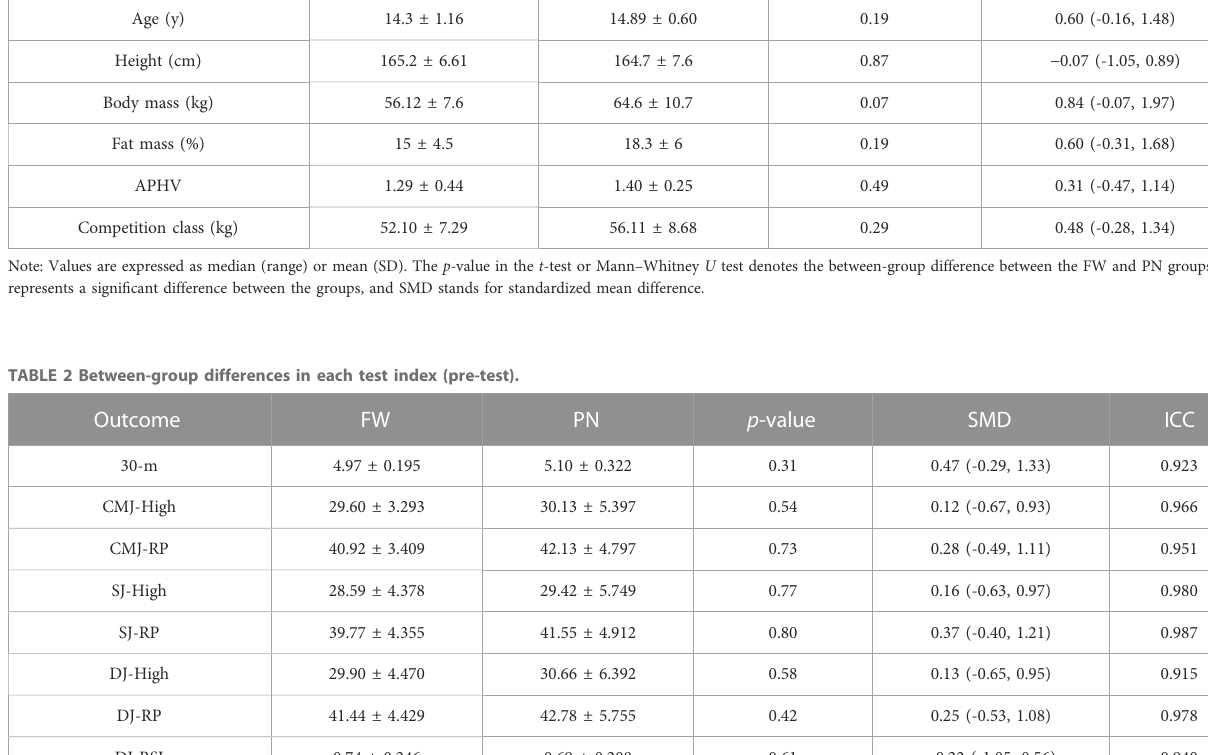
TABLE 1 Participants ’ demographic data.